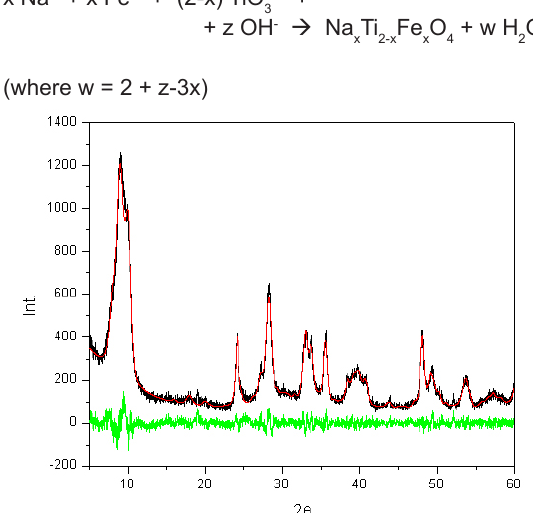
Figure 3. LeBail refinement of the hydrothermal product XRD. Figure 4. (a) EDS spectrum of the nanosheets exhibited in the TEM